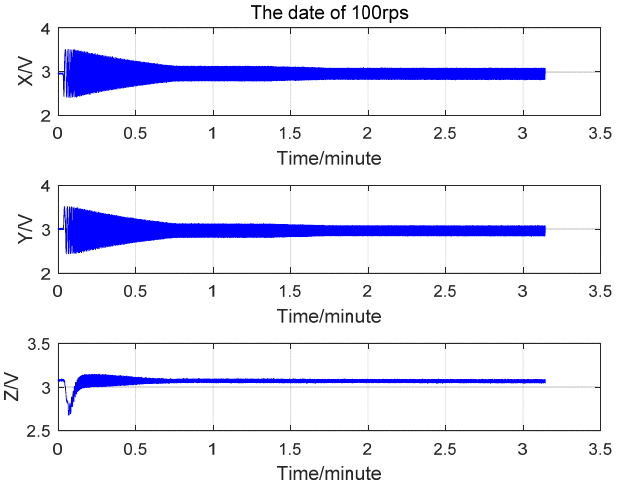
Figure 9. Sensor induction voltage when the single ‐ axle rotary table rate was 100 rps.